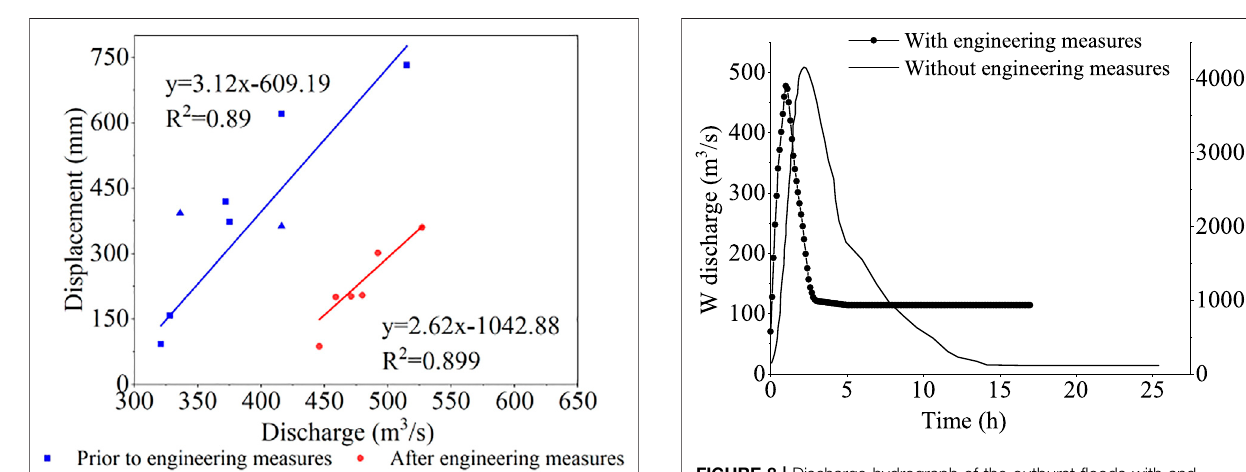
FIGURE 8 | Discharge hydrograph of the outburst fl oods with and without engineering measures (W: with engineering measures, WO: without engineering measures).